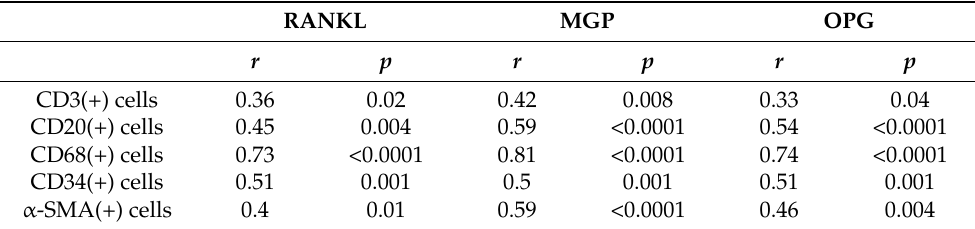
Table 4. Correlation between inflammatory infiltration and vascular calcification regulators.